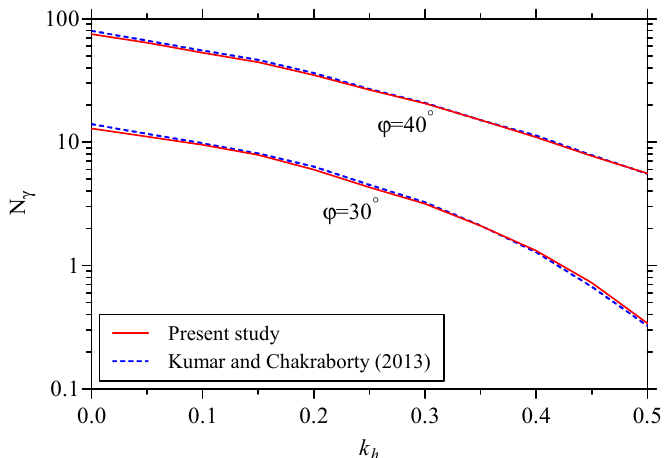
Figure 3. Bearing capacity of the foundation: comparison between the results of the present study and those of [65]. Table 2. Bearing capacity of the foundation: comparison with literature data in terms of the capacity factor N γ . ϕ ( ◦ )